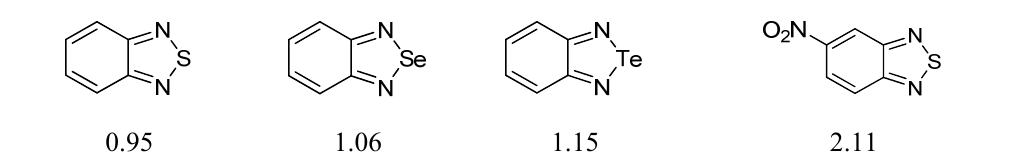
Table 3. (U)B3LYP/6-31+G(d) adiabatic EA (eV) of 2,1,3-benzochalcogenadiazoles and their selected derivatives [56,72,88].